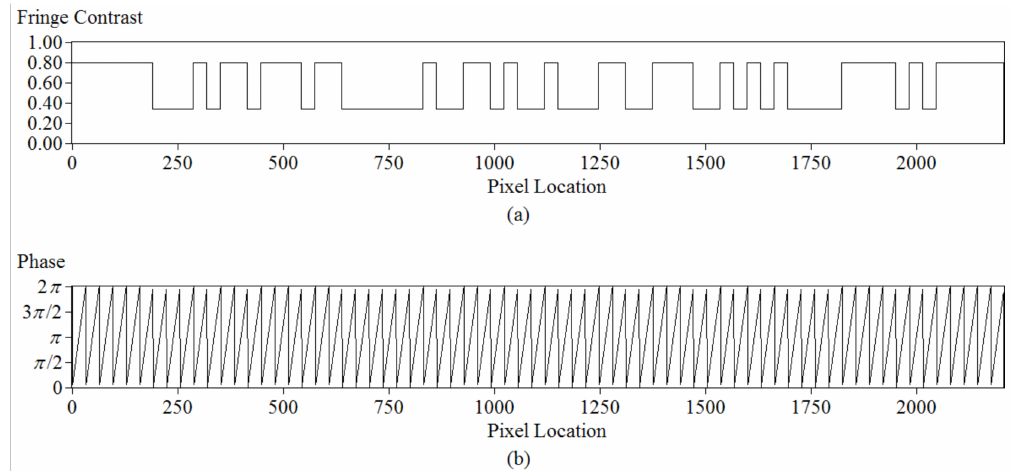
Figure 4. ( a ) The 1D contrast distributions of the five encoded patterns. ( b ) The 1D phase distribution of the five encoded patterns wrapped in the interval (0, 2 π